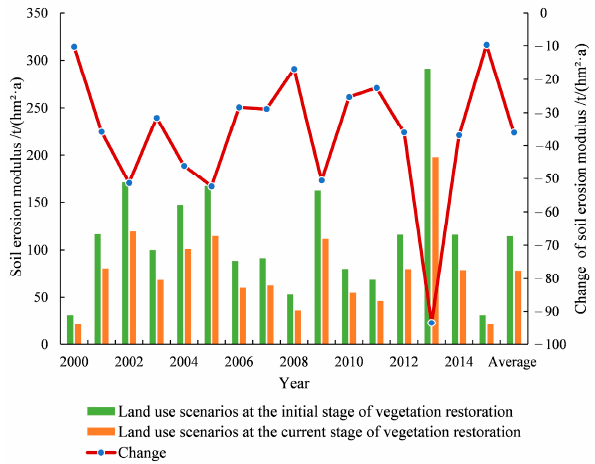
Figure 4. Effects of vegetation restoration on soil erosion from 2000 to 2015. The average soil erosion modulus changes from 2000 to 2015 were divided into two cat- egories, increased erosion (>0) and decreased erosion (<0), based on the reclassification function of ArcGIS 10.6 (Figure 5). During the study period, the areas with